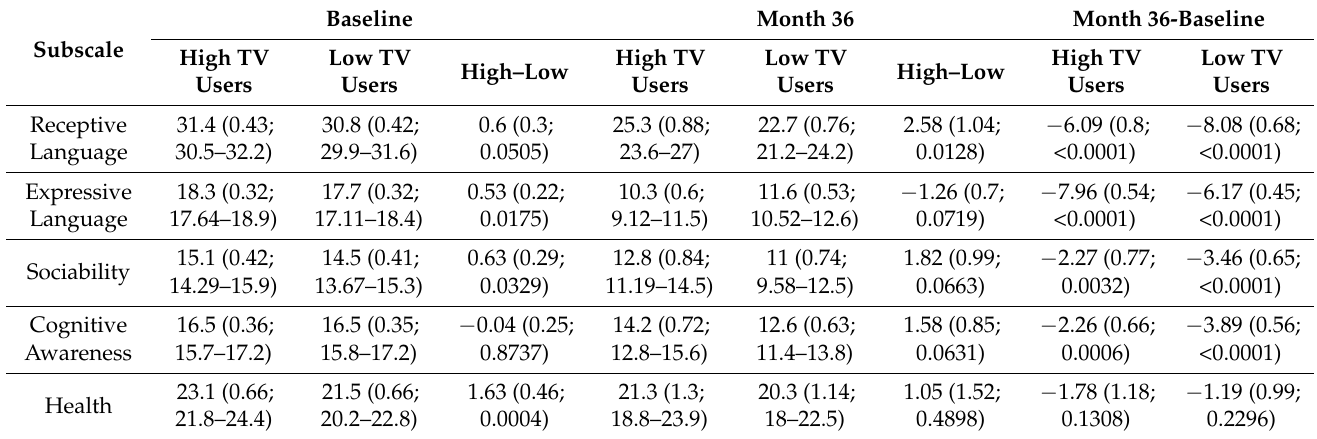
Table 3. Characteristics of high and low TV user quartiles. Data are presented as Least Squares Means (LS Means) (SE; 95% CI). A lower score indicates a lower severity of ASD symptoms. The difference between high TV and low TV quartiles is presented as LS Mean (SE; p -value). The positive high–low difference indicates that high TV users had a higher score and therefore more severe